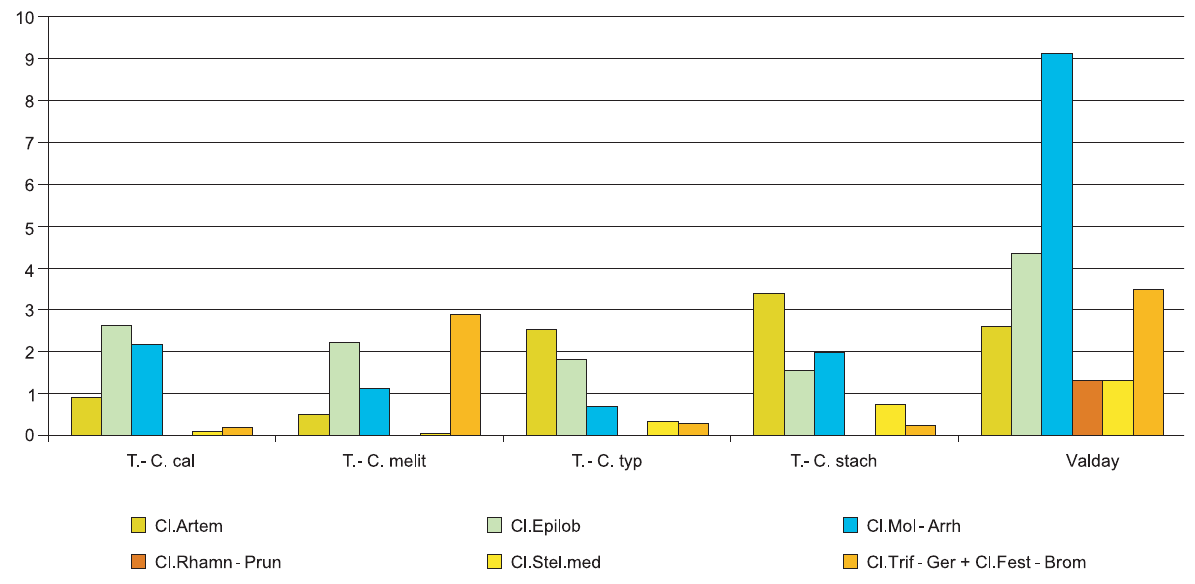
Fig. 3. Total frequency of vascular species characteristic of open habitats in the studied forest complexes Cl.Artem – species characteristic of Artemisietea class (ruderal and forest fringe communities) Cl.Epilob – species characteristic of Epilobietea angustifolii class (clearings communities) Cl.Mol-Arrh – species characteristic of Molinio-Arrhenatheretea class (grassland communities) Cl.Rhamn-Prun – species characteristic of Rhamno-Prunetea class (shrub communities) Cl.Stel.med – species characteristic of Stellarietea mediae class (segetal and ruderal communities) Cl.Trif-Ger + Cl.Fest-Brom – species characteristic of Trifolio-Geranietea and Festuco-Brometea classes (thermophilous tall herbs and grassland